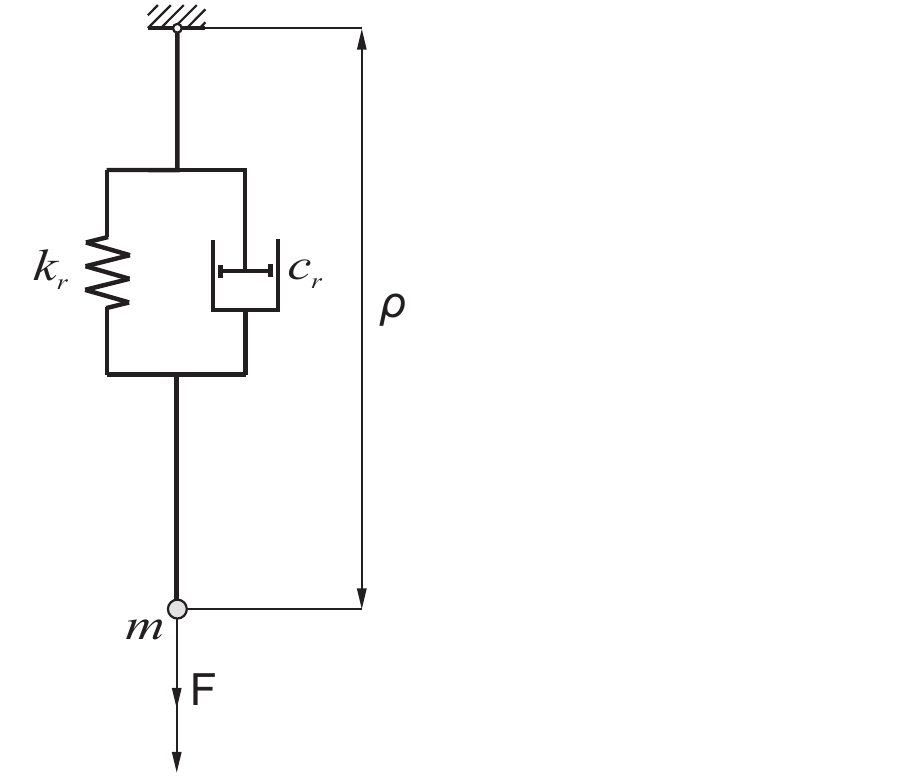
Figure 5. Graphical representation of rope modeling in the SolidWorks program. Kinematic constraints (Figure 6) have been implemented into the model in the form of displacement segments of appropriate members. Based on the implemented displace- ments, the SolidWorks program calculates velocities and accelerations, respectively. Cubic interpolation was selected as a function of the default segment type [1].